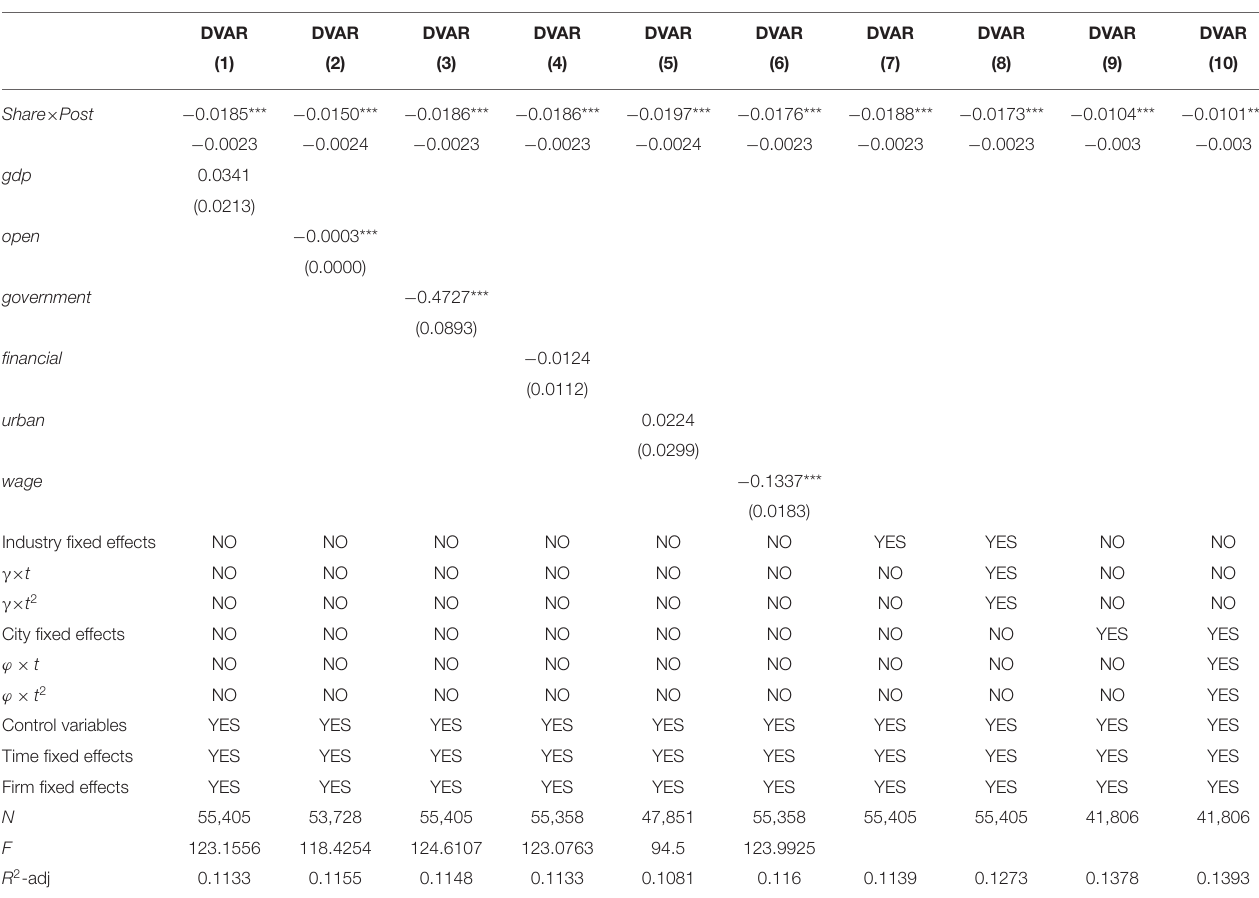
TABLE 5 | Investigation of macro